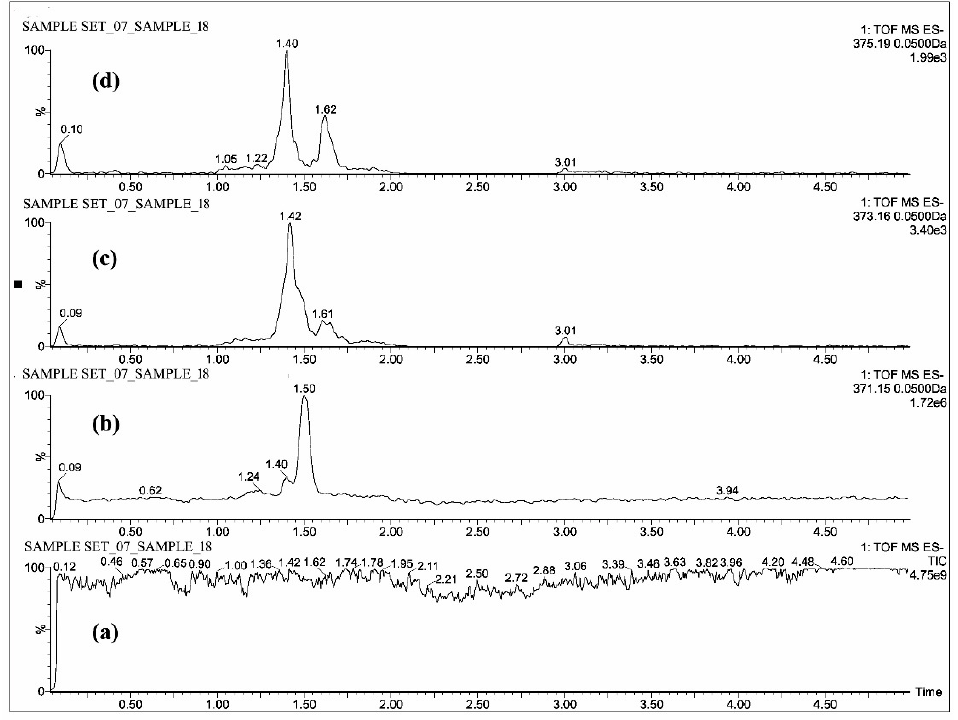
Figure 5. UPLC-QTOF-MS chromatograms of a plasma sample—( a ) total ion chromatogram of curcuminoids and COG, extracted ion chromatograms of ( b ) CUR, ( c ) DMC, ( d ) BDMC and ( e ) COG.